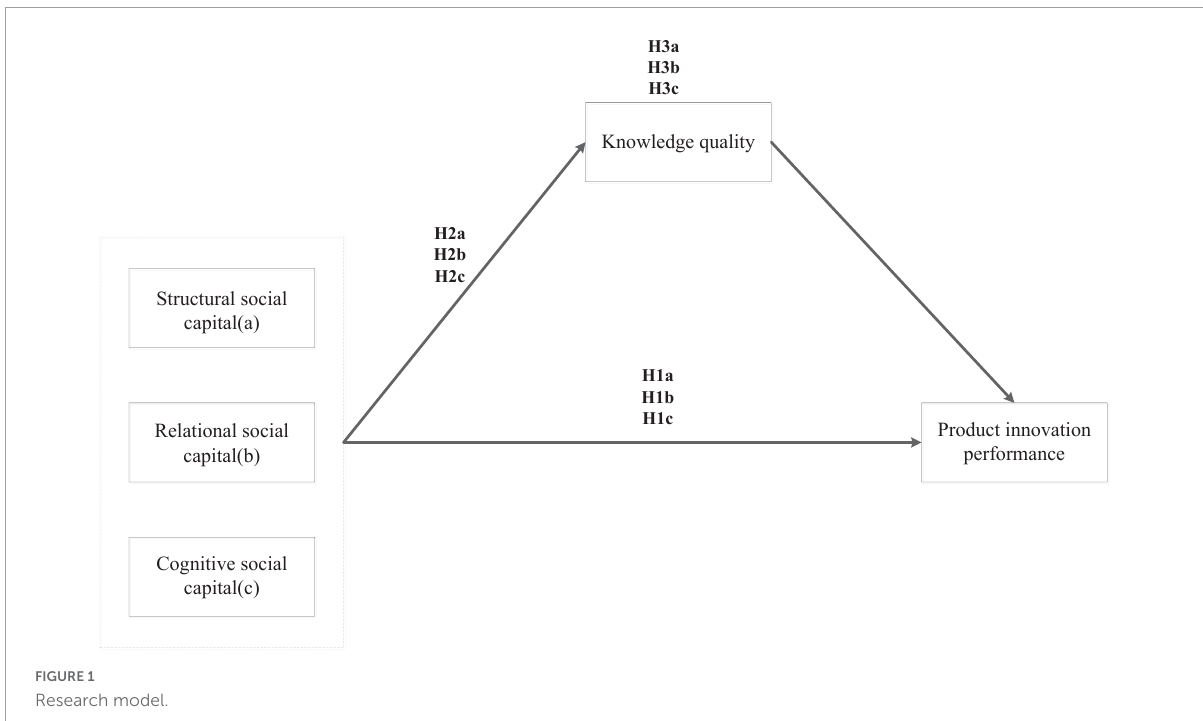
FIGURE1 Research